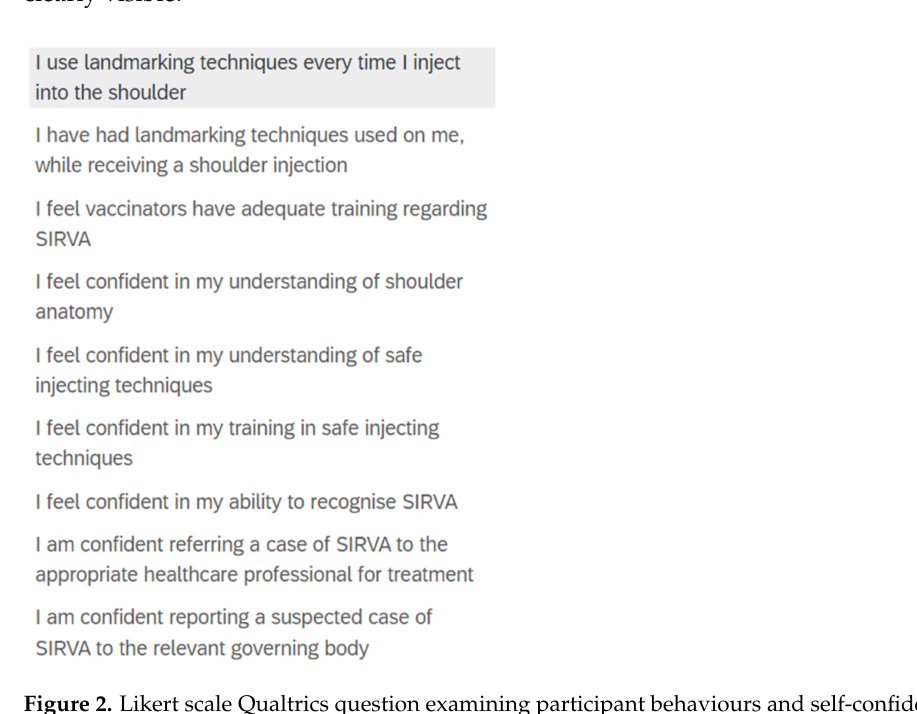
Figure 2. Likert scale Qualtrics question examining participant behaviours and self-confidence.